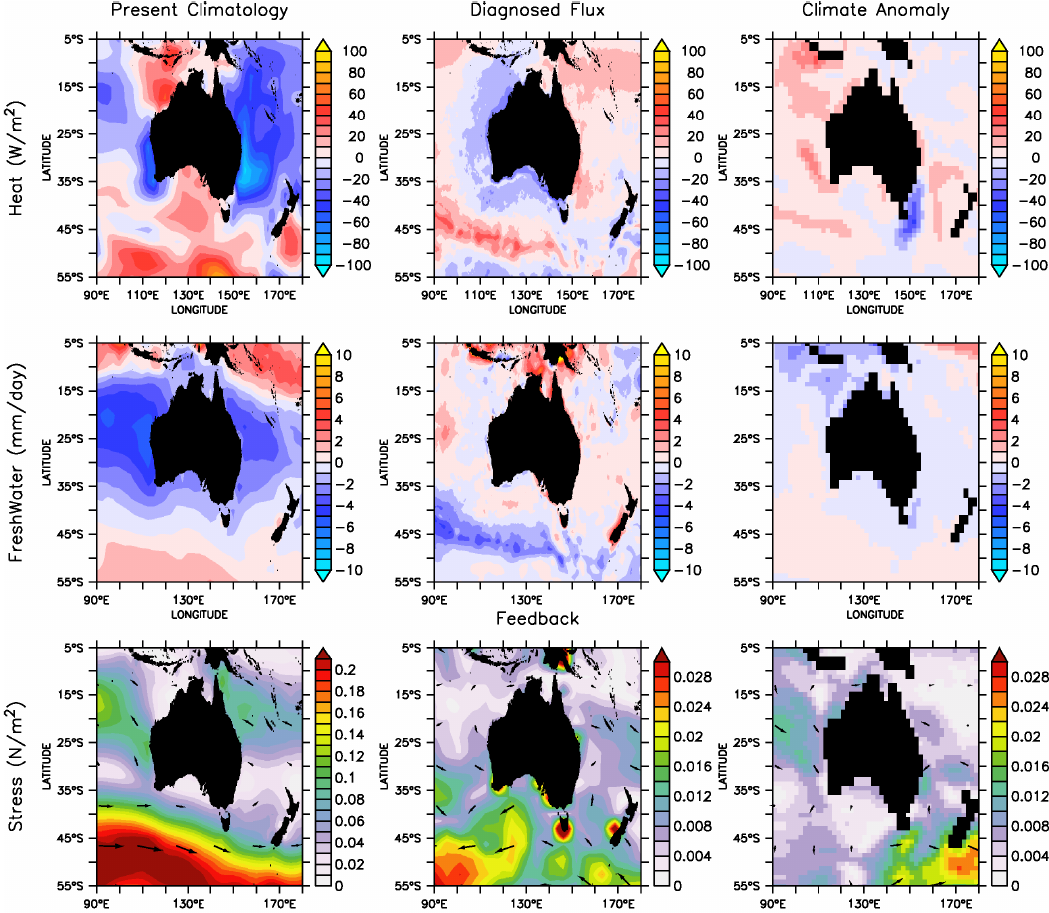
Fig. 4. Average forcing fields of heat (top), freshwater (middle) and surface stress (bottom) applied to ODM experiments. Forcings from present climatology are in the left column, climate anomalies in the right. The centre column shows the diagnosed fluxes for heat and freshwater based on the ODM spinup as the ocean was restored to observed surface fields, and the ocean feedback calculated to surface stress (see Sect.